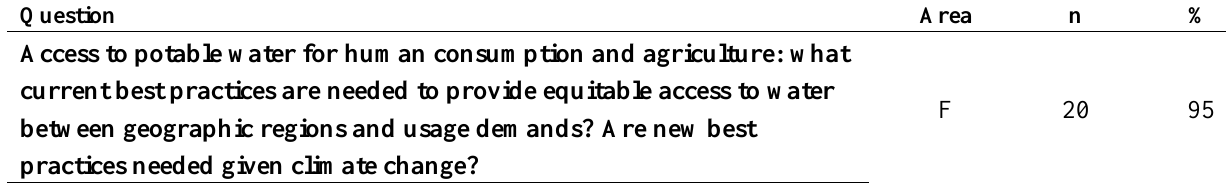
Table 2. Agreement (>90%) to include question as a research priority. NB: Questions also presented in Table 3 are in